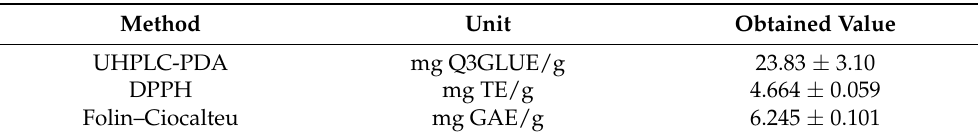
Table 6. Quantification of the antioxidant compounds in the M. oleifera extracts and determination of their antioxidant